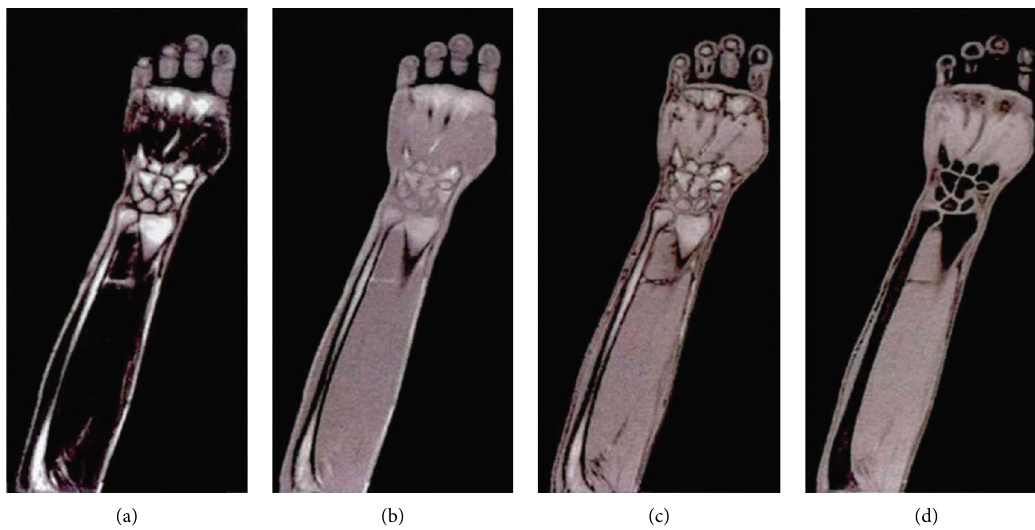
Figure 21: Four diferent contrast images of the forearm reconstructed by using mDIXON-FFE sequence scanning: (a) the fat phase image; (b) the in-phase diagram; (c) the out-phase image; (d) the water phase image.